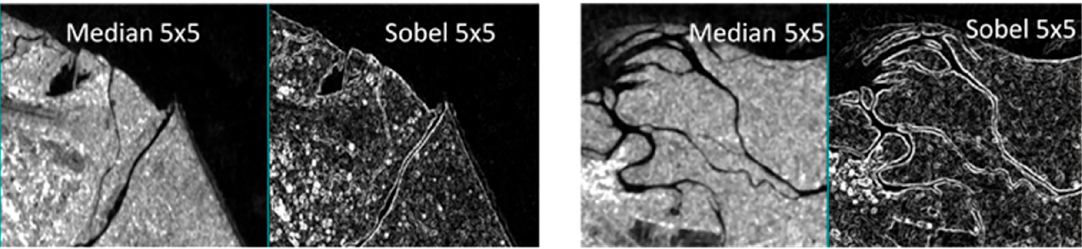
Figure 7. Median and Sobel filters with a kernel size of 5 × 5 .